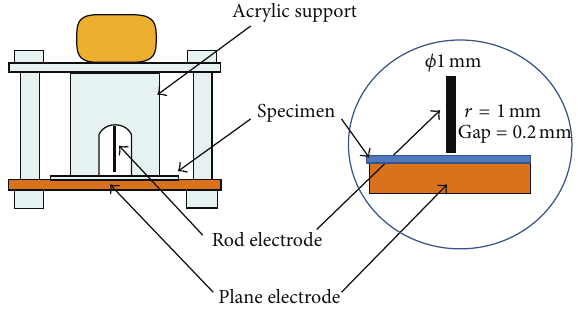
Figure 11: Rod-to-plane electrode system configuration with the 0.2 mm air gap [28].